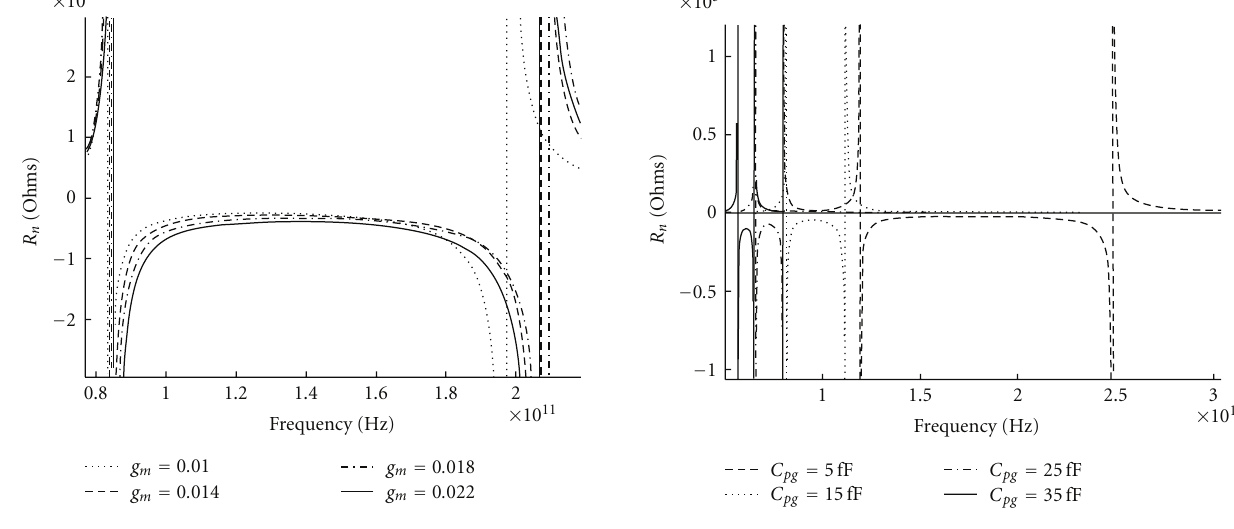
Figure 3: Variation of R n with g m . Figure 4: Variation of R